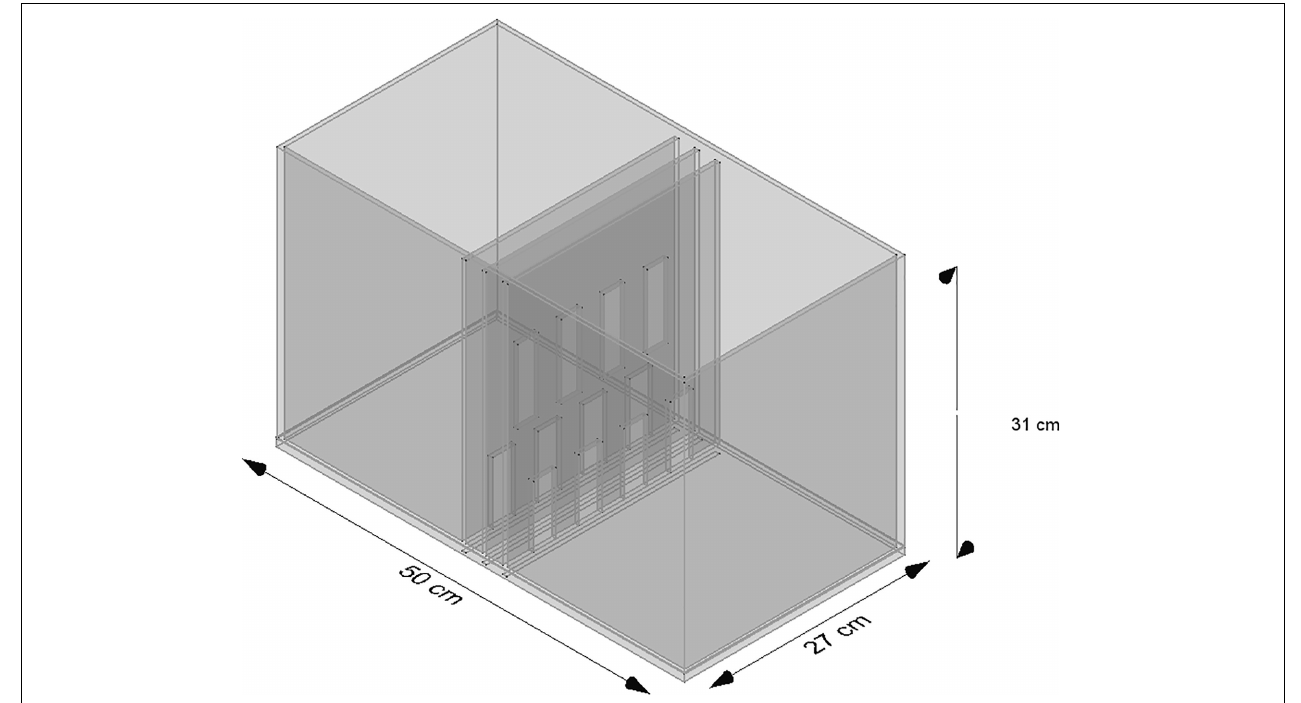
FIGURE 1 | Scheme of the standard NCE cage. Two compartments are separated by three partitions, namely, two outer partitions with identical perforations and one middle partition with perforations shifted